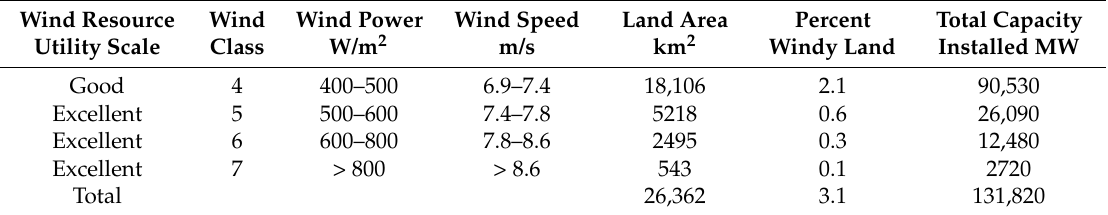
Table 1. Pakistan wind electric potential, good to excellent wind recourses at 50 m.